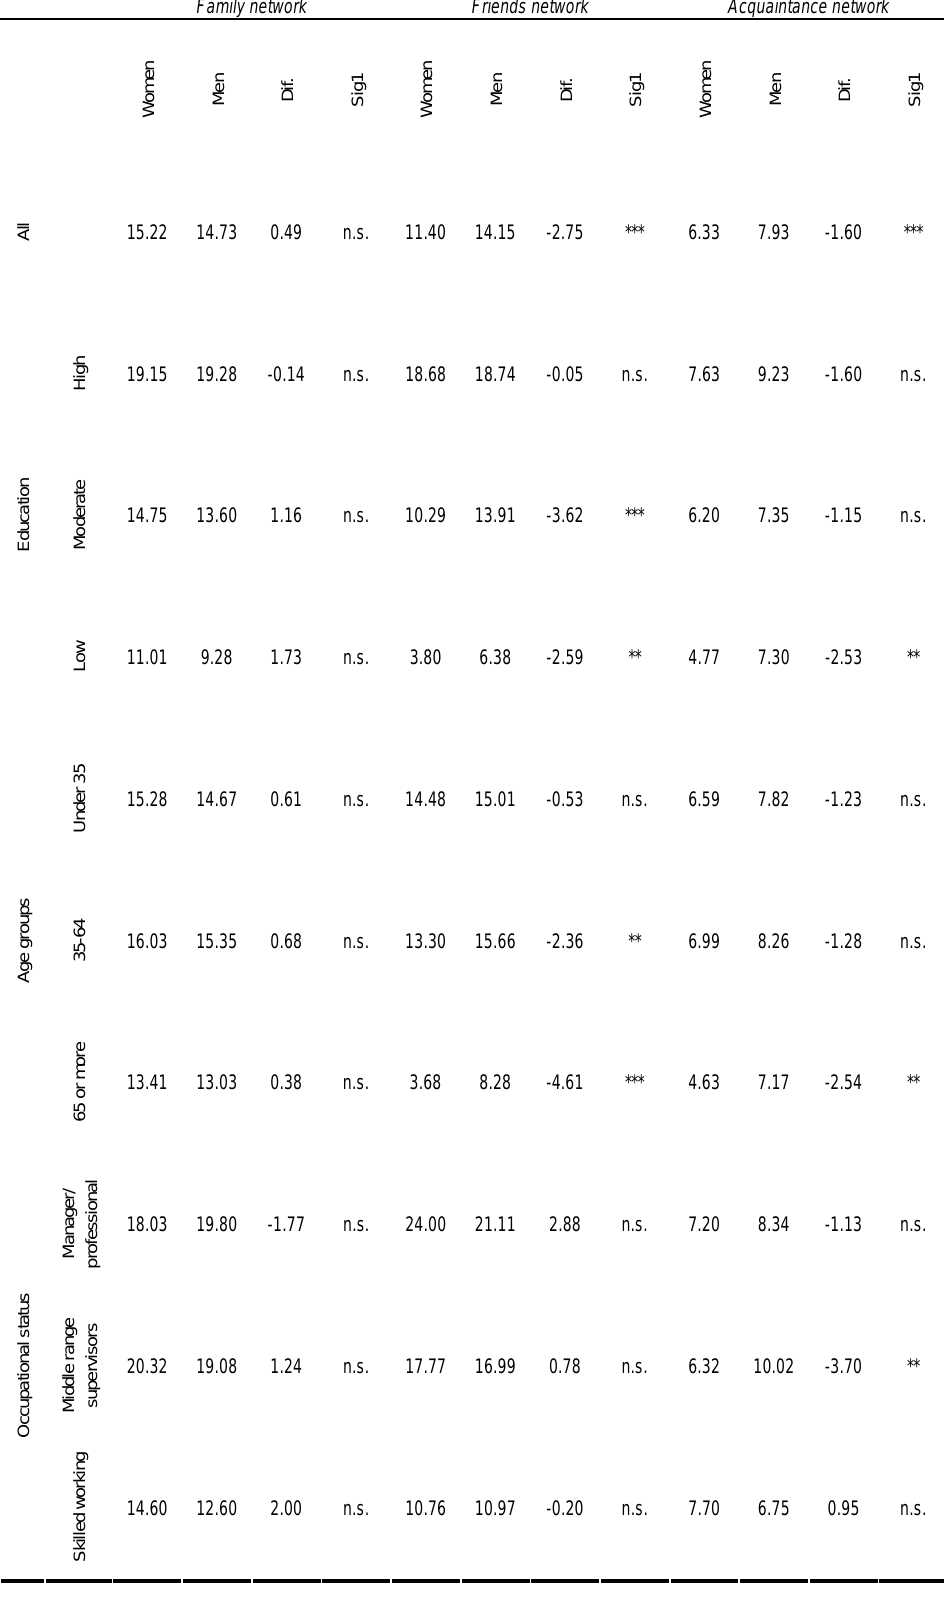
Table 5. Mean of type of network according to gender and control variables Family network Friends network Acquaintance